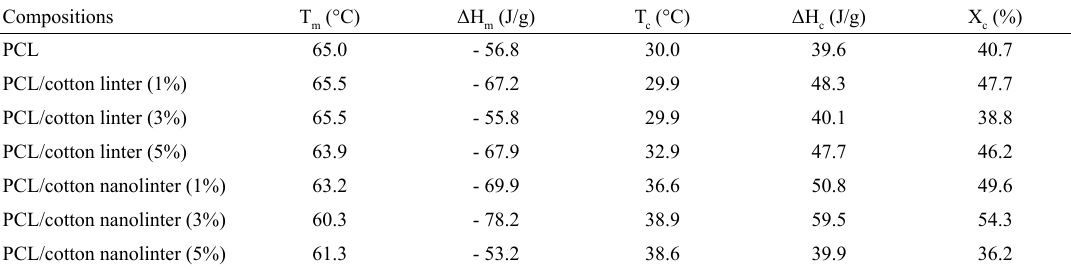
Table 3: Characteristic temperatures, enthalpies of fusion and crystallization, and degree of crystallinity for PCL/cotton linter and PCL/ cotton nanolinter compounds. Compositions